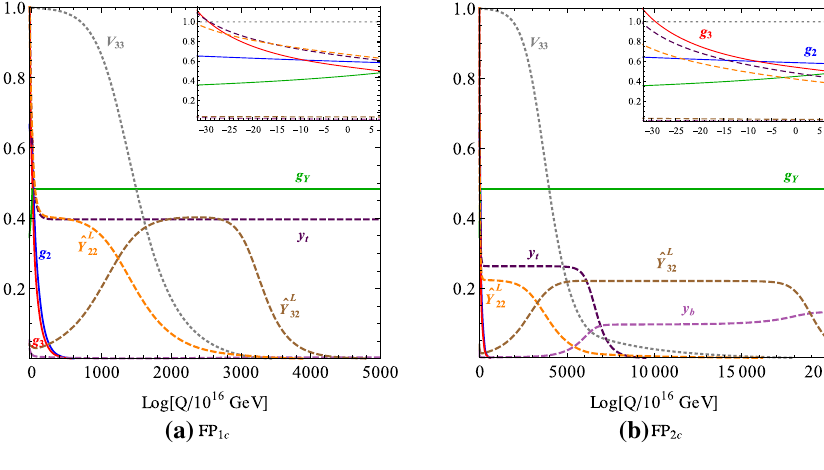
Fig. 3 RG flow of the gauge and Yukawa couplings from the trans-Planckian energies down to the EWSB scale for scenarios featuring the fixed point a FP 1 c , and b FP 2 c . The sub-Planckian flow is depicted in the inset panels